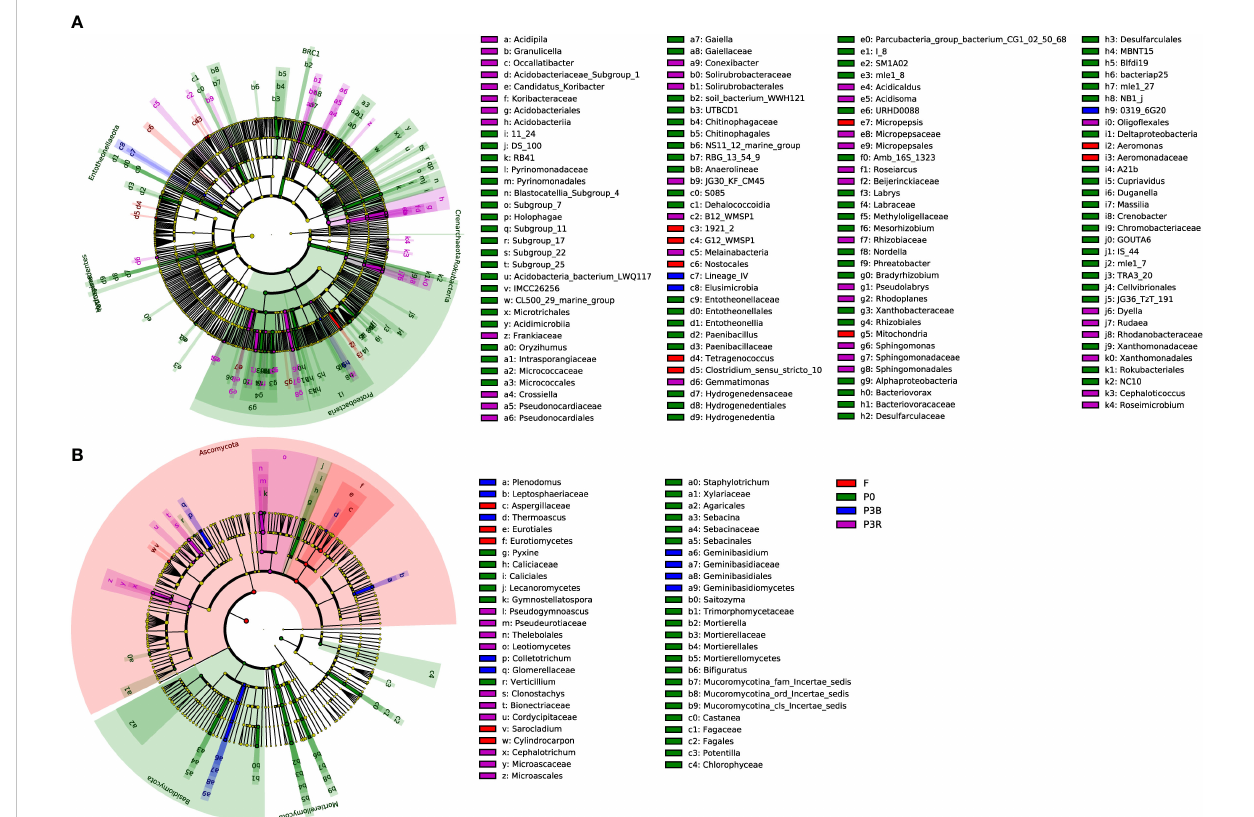
FIGURE 6 Histogram and cladogram based on the LEfSe analysis of soil microbial communities. (A) Bacteria; (B) Fungi. Indicator bacteria with LDA scores of 2.5 or greater. P0, control soil; F, one-year fallow soil; P3R, Rhizosphere soil after three years consecutive monoculture; P3B, Bulk soil after three years consecutive monoculture.